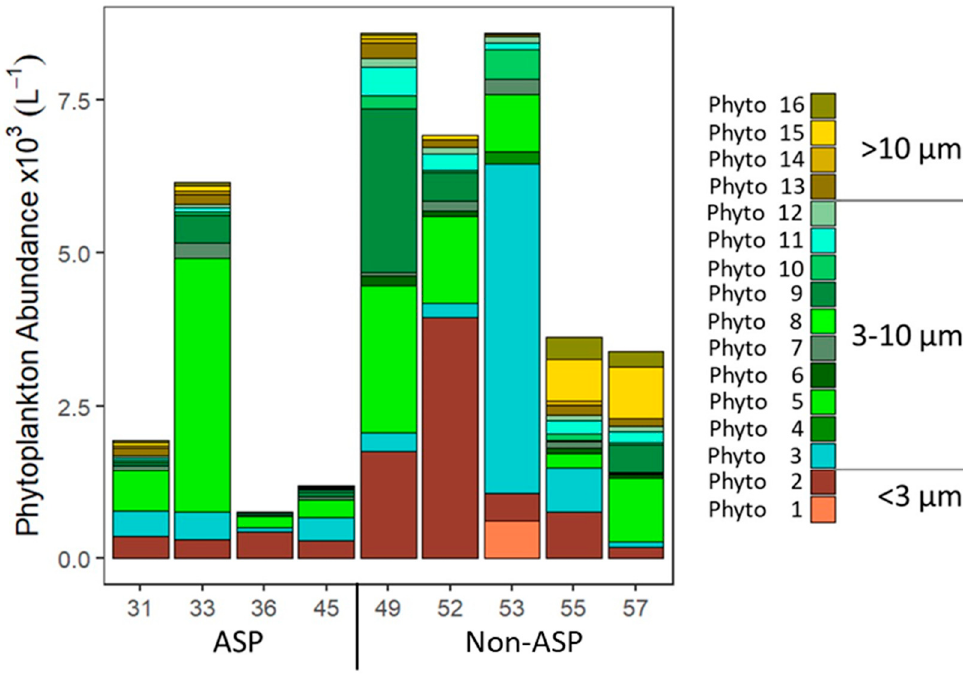
Figure 3. Phytoplankton populations, clustered in picophytoplankton (<3 um average cell diameter; Phyto 1 and 2), nano-sized phytoplankton populations 3-10 um (Phyto 3–13), and >10 um (Phyto 14–17). Stations 31–45 lie within the Amundsen Sea Polynya (ASP) and stations 49–57 outside of it.